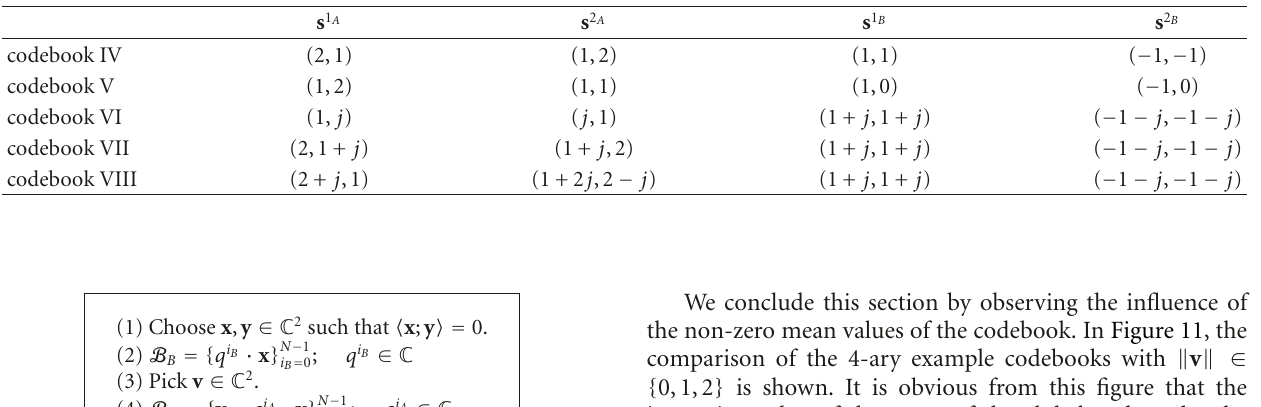
Table 3: Example (nonorthogonal) binary E-PHXC codebooks.